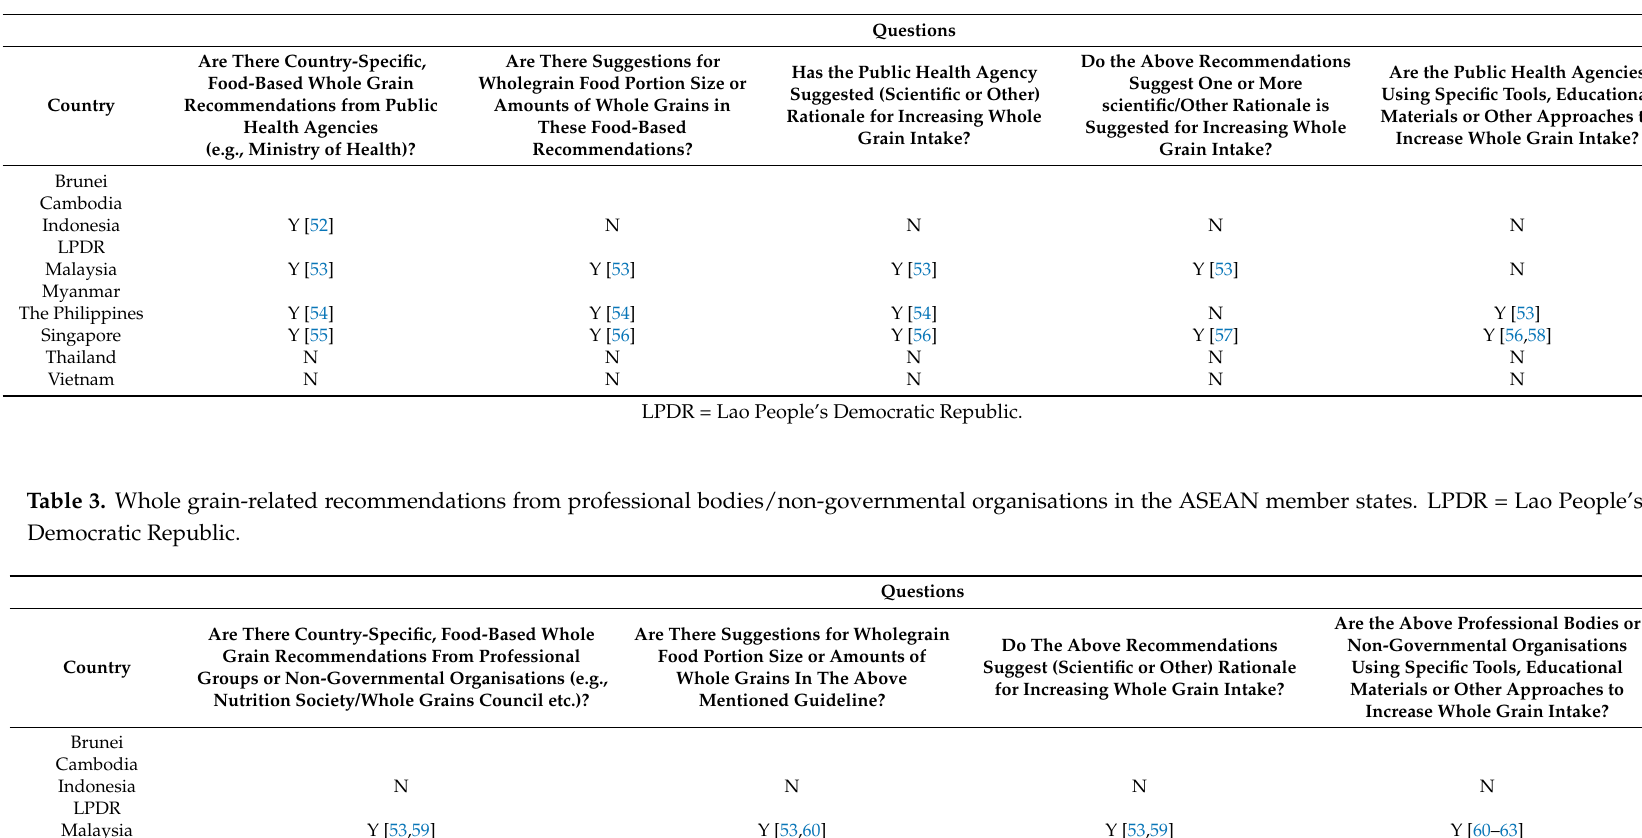
Table 2. A summary of whole grain-related public health recommendations in the ASEAN member states.